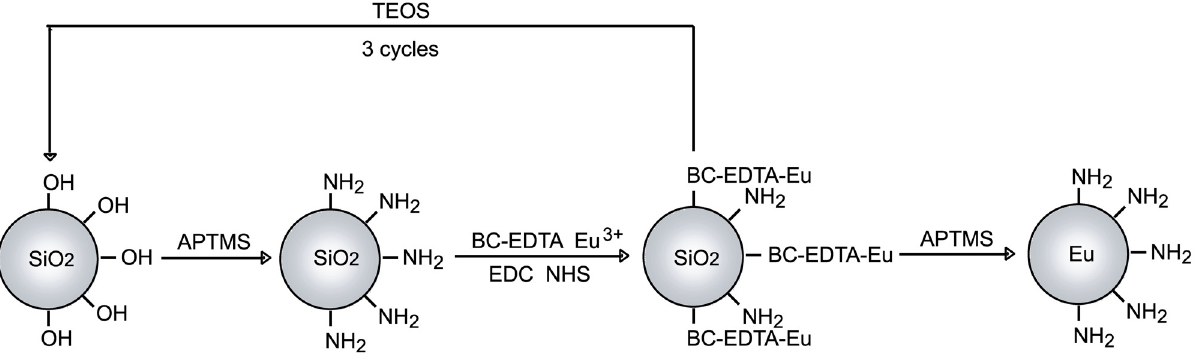
Fig 3. Outline of labeling bare particles with